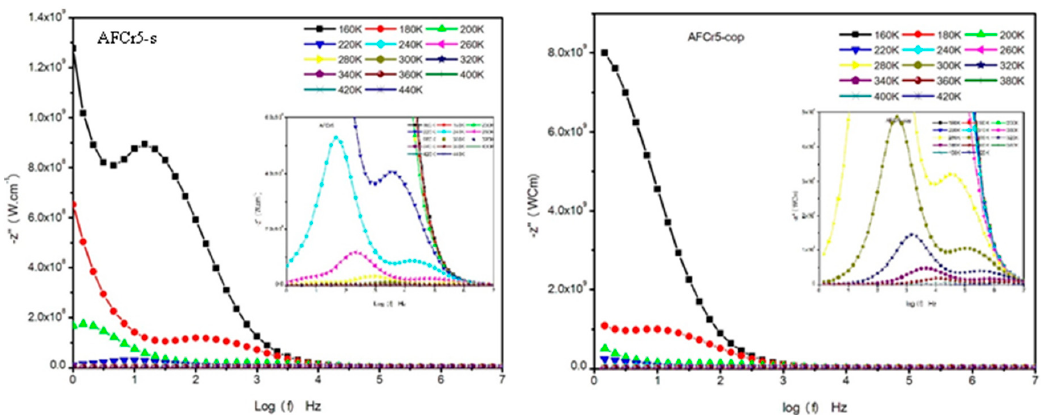
Figure 5. Frequency evolution of M” (imaginary part of electric modulus) at different temperatures for AFCr5-s and AFCr5-cop.